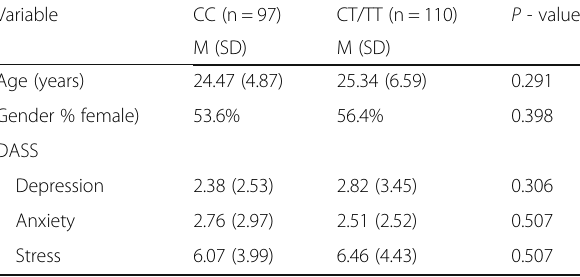
Table 1 Demographic characteristics of the different